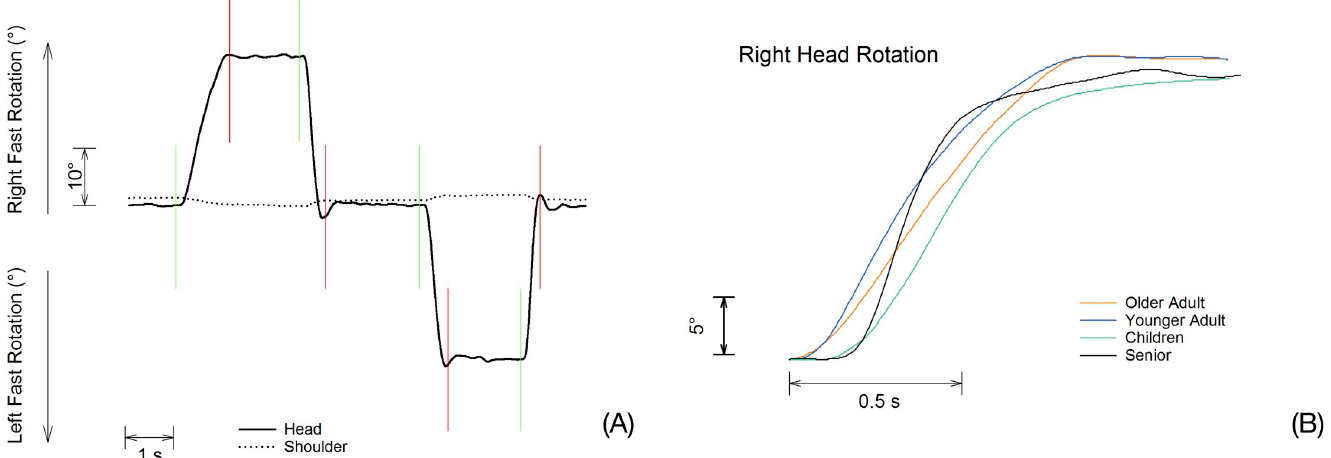
Fig 3. Typical trace during one complete cycle and example of different performances achieved by individuals of different age-group. (A) Typical trace of head- neck complex and trunk rotation during one complete cycle (center-right-center-left-center). Analysis was conducted during head rotation (ascendant/descendant solid line) phase with placement of cursors from the beginning (green) to the end of the rotation (red). (B) Example of right axial rotation performed by individuals of different age-group.